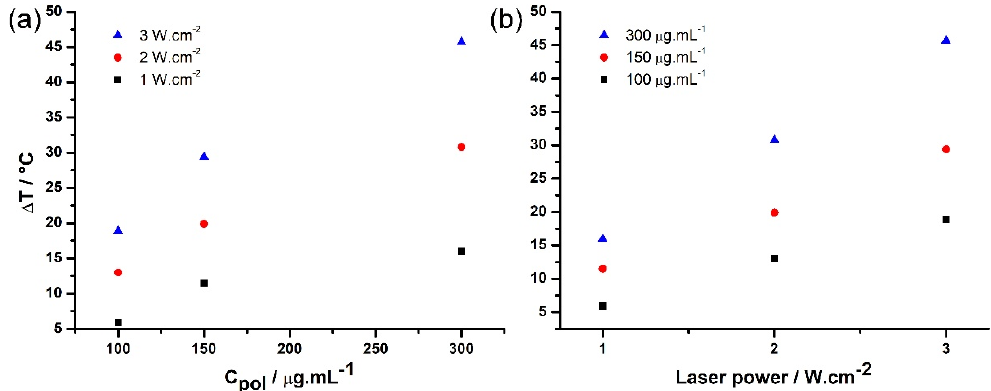
Figure 8. Temperature increase ( Δ T) recorded as a function of the concentration of polymer ( a ) and of the laser power ( b ) (each point corresponds to a single measurement).